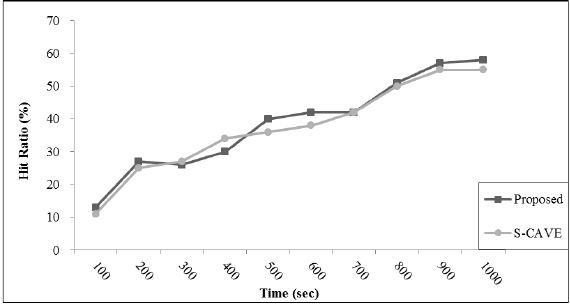
Fig. 8. The comparison of hit ratio of different